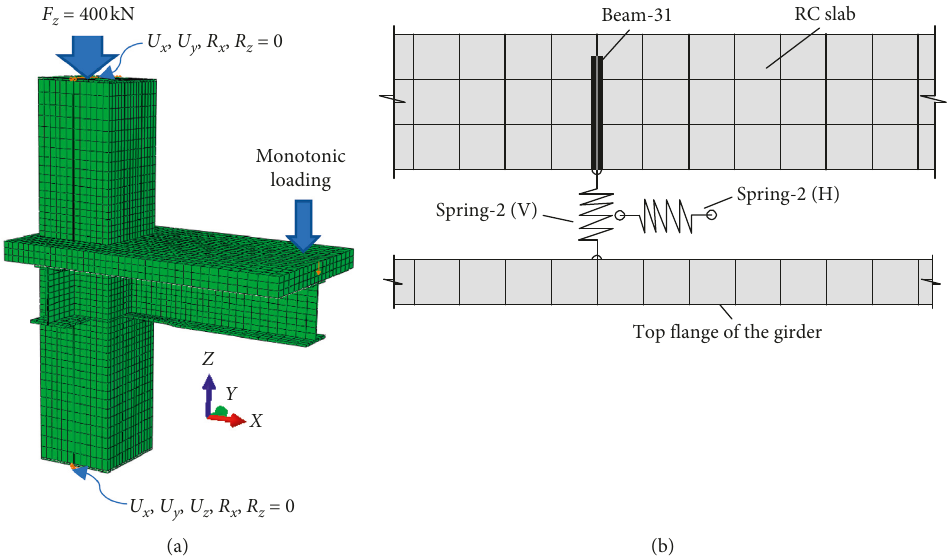
Figure 7: FE model: (a) typical meshing, boundary condition, and loading on the model of specimens; (b) modelling skill of a